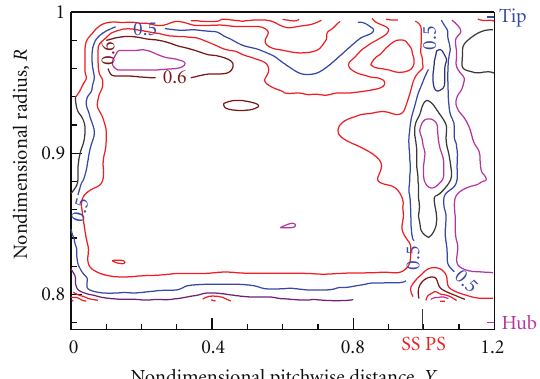
Figure 11: Axial velocity contours at the exit of rotor (wps) for φ = 0 . 55.